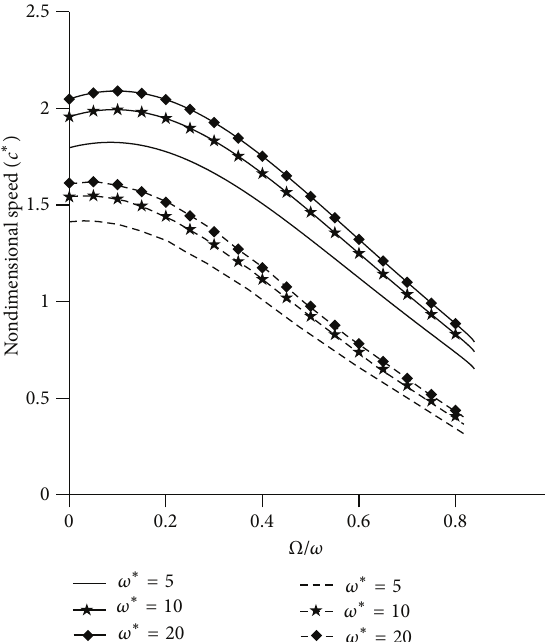
Figure 1: Variations of the nondimensional speed of Rayleigh wave against rotation-frequency ratio (solid lines:orthotropic micropolar elastic case, dotted lines:isotropic micropolar elastic